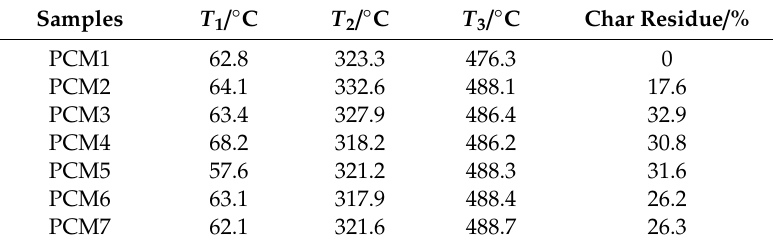
Figure 4. Di ff erential thermogravimetry (DTG) curves of PCMs. Table 3. Mass loss temperatures of